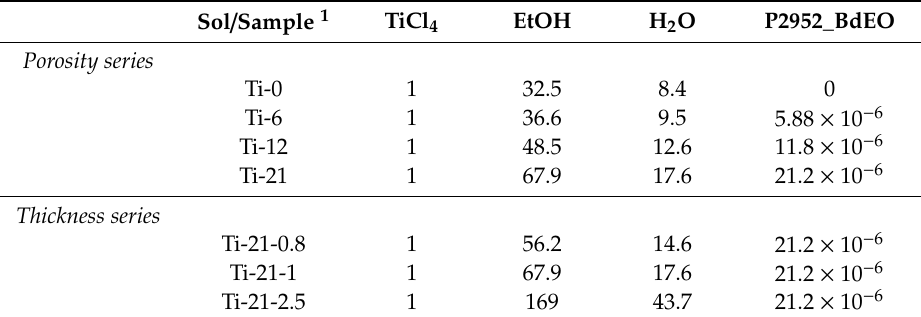
Table 1. Molar compositions for the dip coating sols used in this